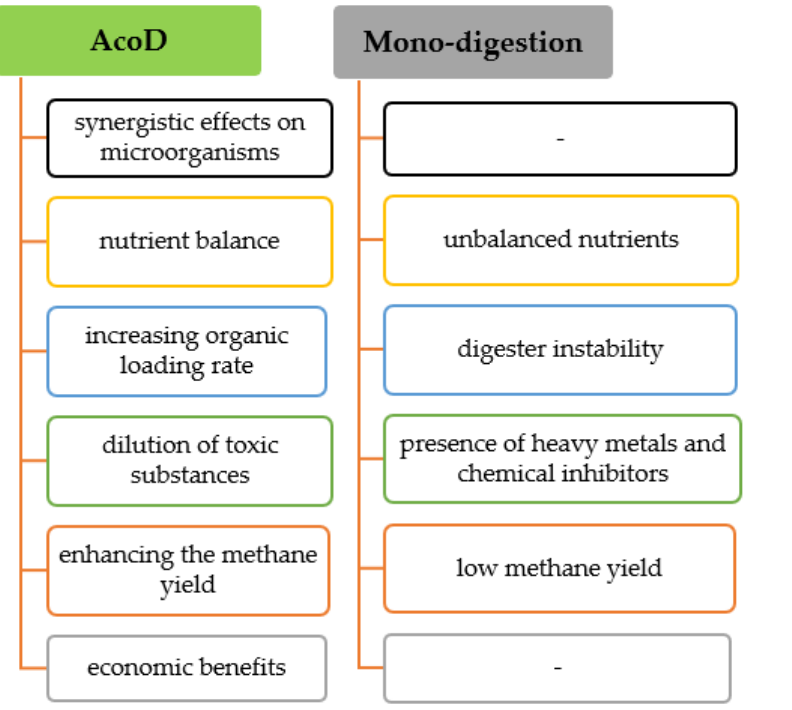
Figure 1. Advantages of AcoD technology compared with mono-digestion process (adapted from [5]).